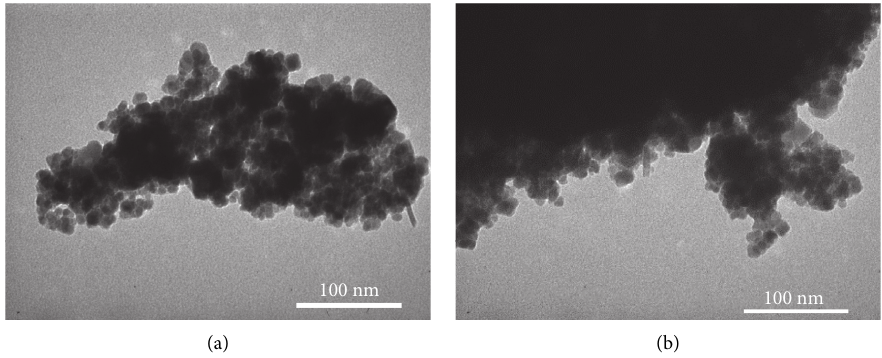
Figure 5: TEM images of the AC-Fe